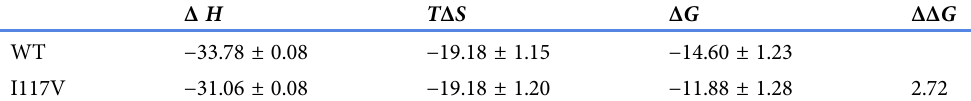
Table 1 Calculated binding free energies (in kcal mol − 1 ) for oseltamivir to the wild-type (WT) and I117V mutant in fl uenza neuraminidase obtained from the MM-PBSA calculations. Δ H T Δ S Δ